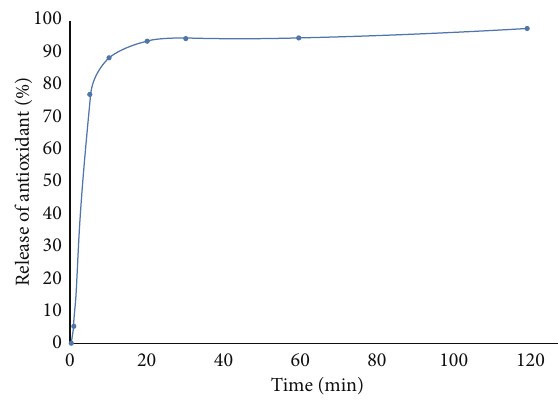
Figure 2: Release profile of antioxidant from encapsulated powder containing antioxidant-rich algal extract obtained by SC-CO 2